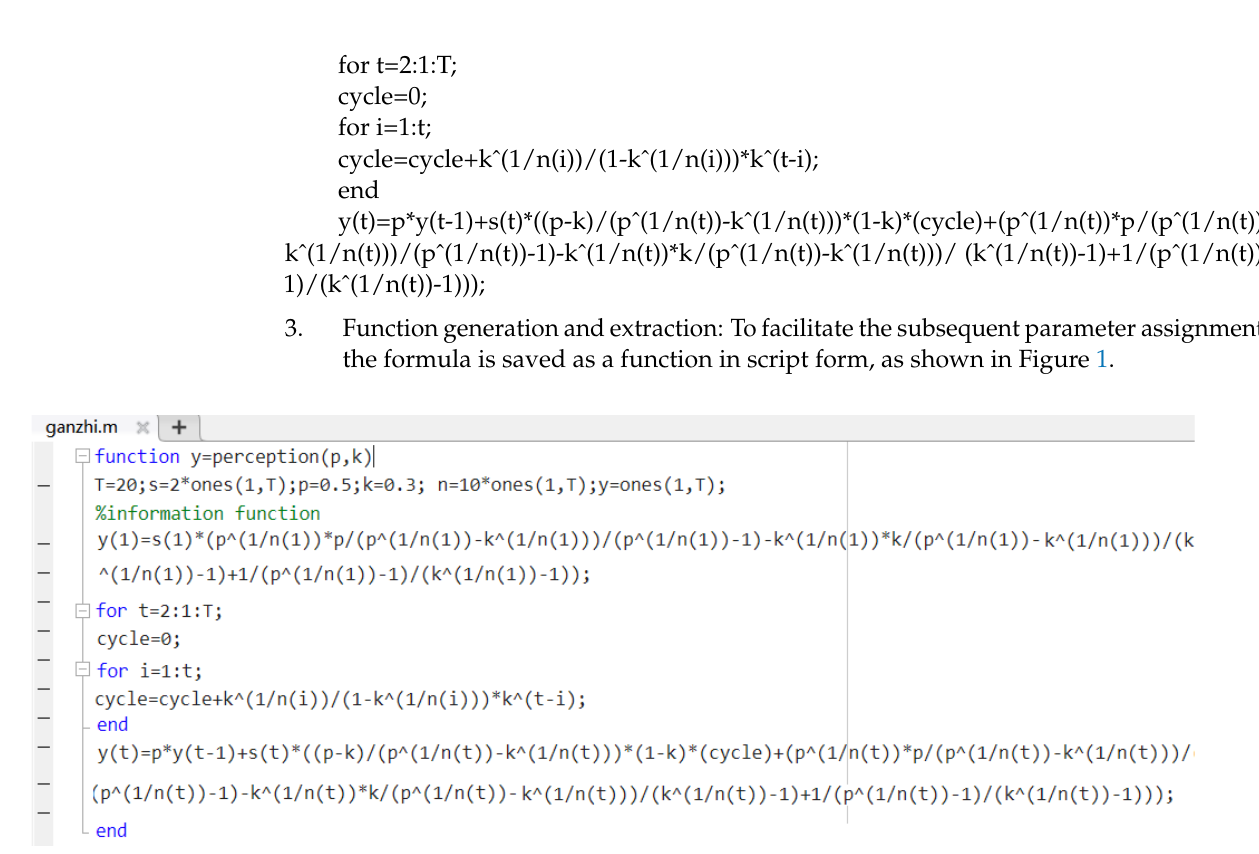
Figure 1. Functions of the risk perception in (p, k).